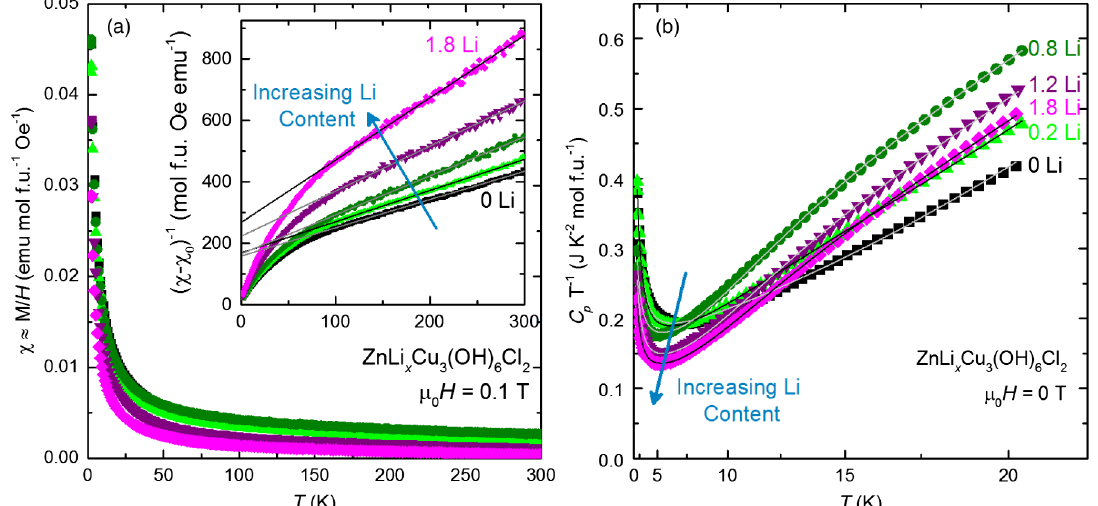
3. Physical properties of ZnLi x Cu 3 ð OH Þ 6 Cl 2 series. (a) The magnetic susceptibility, χ ≈ M=H , as a function of temperature for the doped ZnLi x Cu 3 ð OH Þ 6 Cl 2 series. Black and gray lines are from high-temperature Curie-Weiss analysis of the χ 0 -corrected inverse magnetic susceptibility (inset). All samples have paramagnetic behavior and a decrease in susceptibility is seen as Li content increases. (b) Heat capacity divided by temperature as a function of temperature under zero field from T ¼ 1 . 8 – 20 K. The low-temperature region systematically decreases with increasing Li content across the series, while at higher temperatures the doped samples have increased entropy. Black and gray lines represent fits to the